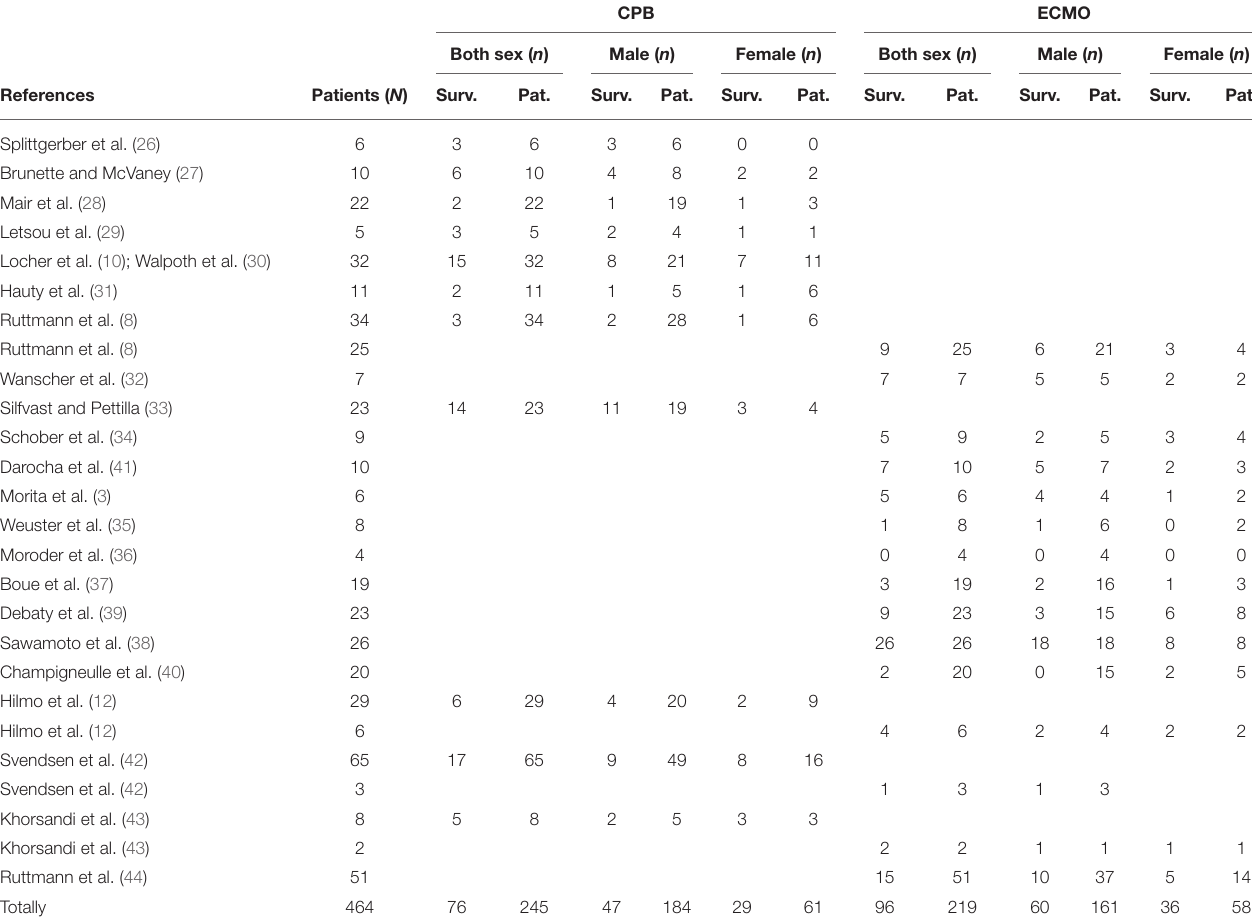
TABLE 2 | Survival of totally 464 victims of hypothermic cardiac arrest sorted by gender and ECLS rewarming technique (CPB or ECMO) in 23 observational studies. CPB ECMO Both sex ( n )